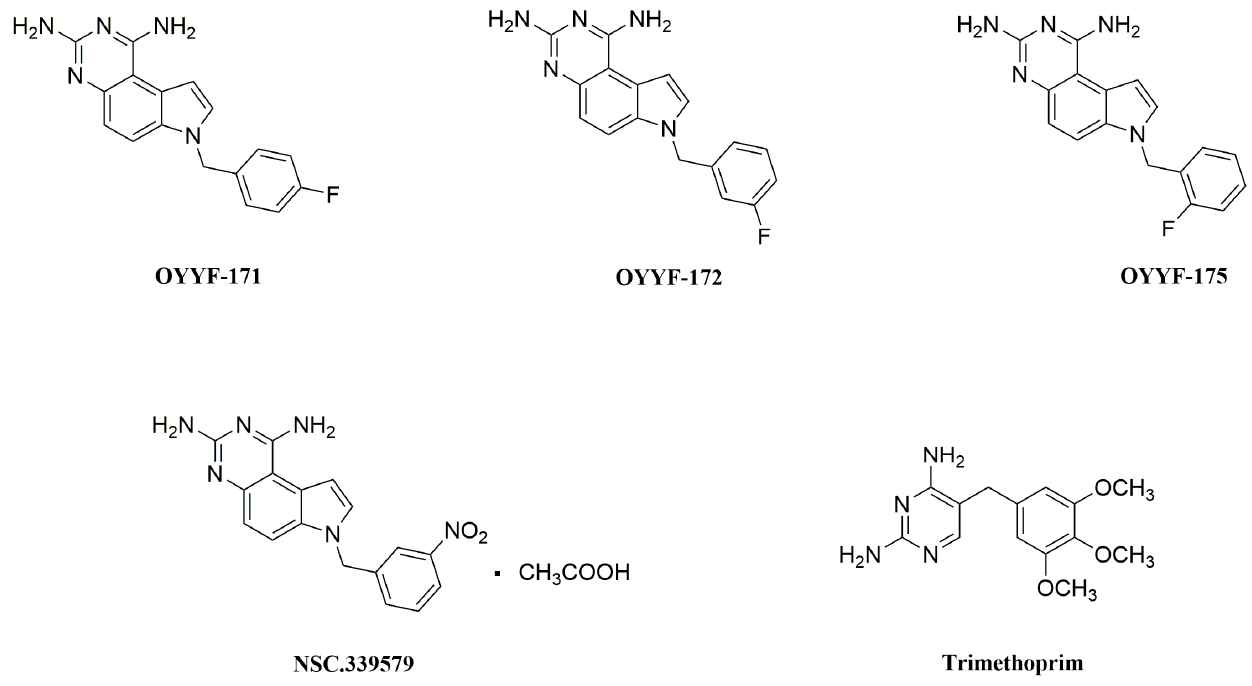
Figure 2. Chemical structures of NSC-339579, OYYF-171, OYYF-172, OYYF-175, and TMP.